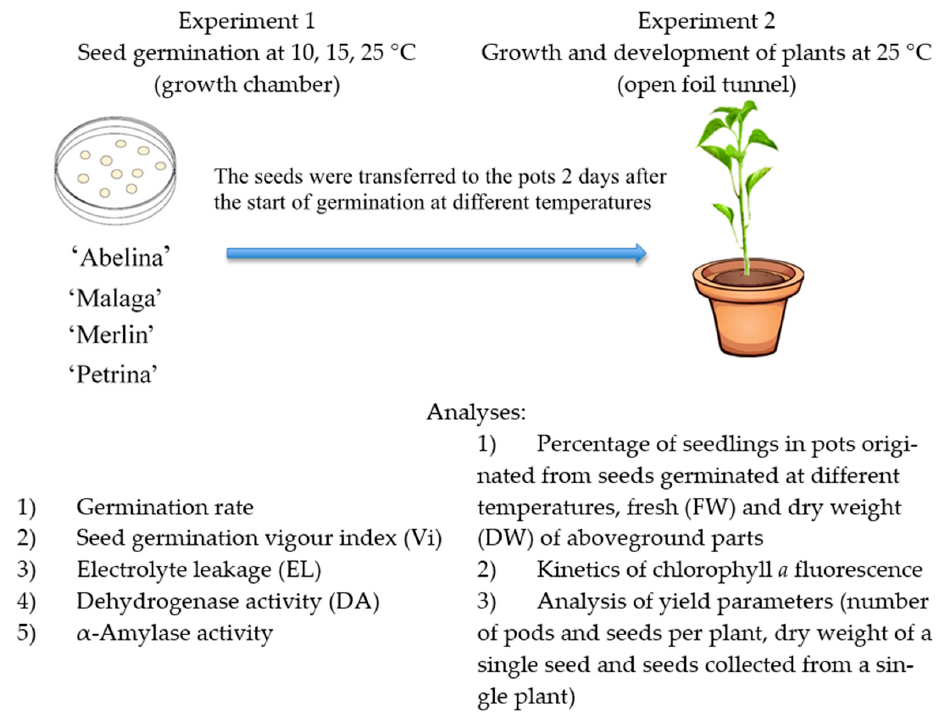
Figure 1. Design of the experiments carried out between May and September 2020.